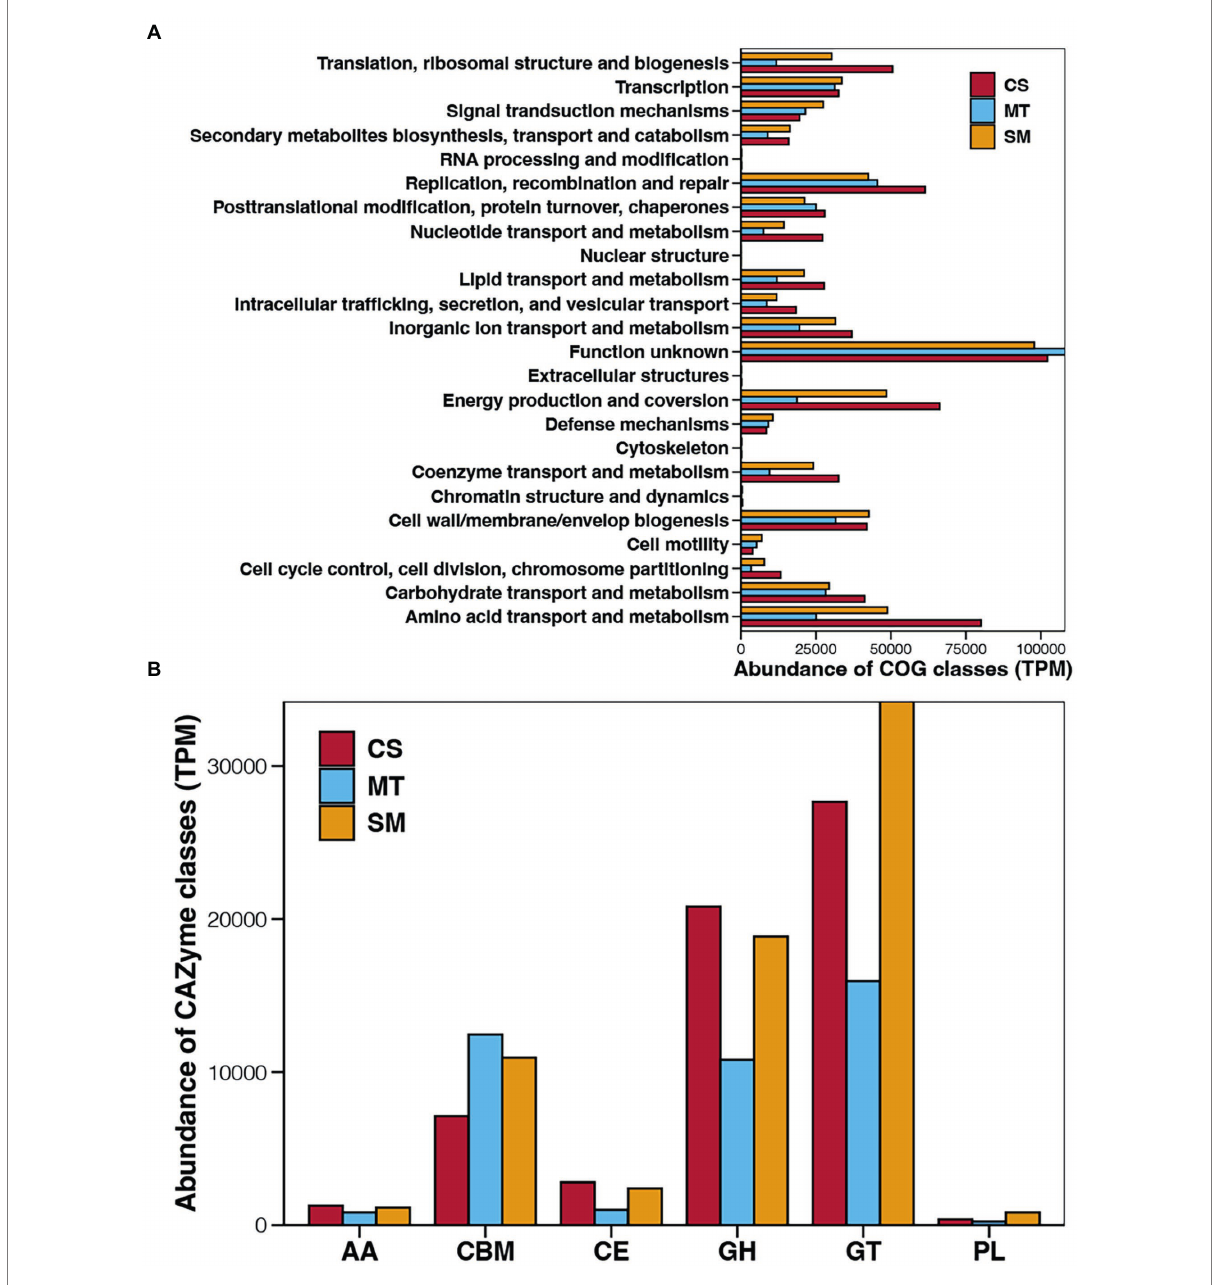
FIGURE 3 Abundances of COG (A) and CAZyme (B) classes in sediments from CS, MT, and MS groups. AA, auxiliary activity; CBM, carbohydrate-binding module; CE, carbohydrate esterase; GH, glycoside hydrolases; GT, glycosyl transferase; and PL, polysaccharide